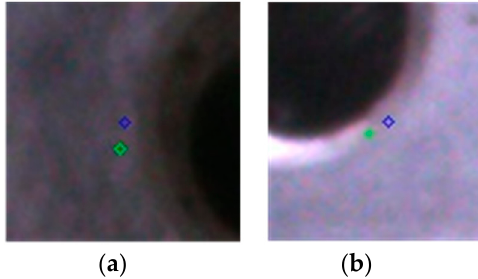
Figure 3. The results of Haar-like feature matching. ( a ) Low brightness; ( b ) High brightness.